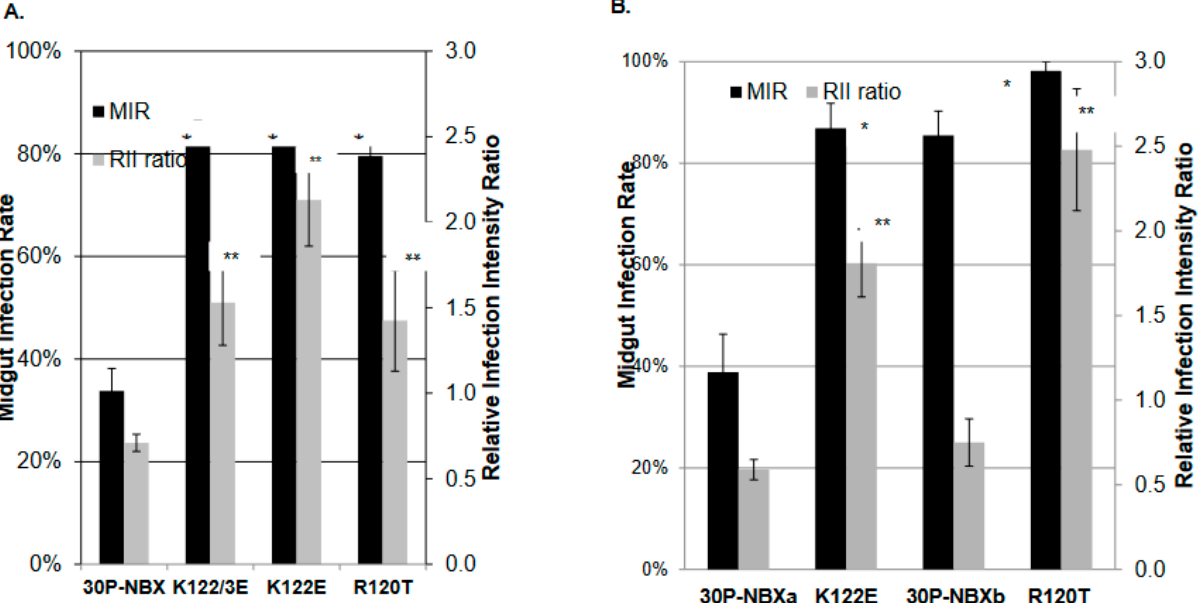
Figure 4. Virus MIRs and relative infection intensity (RII) ratios in Ae. aegypti RexD mosquito midguts ( A ) and Chetumal mosquito midguts. Mosquitoes were orally challenged with each virus, maintained for seven days until midguts were dissected, and MIRs and RII ratios were determined by IFA. In ( B ), 30p-NBXa and 30P-XNXb are data for internal controls for K122E and R120T, respectively. Data are the average of at least three experiments and significance of MIR (*) and RII ratio (**) differences were determined by comparison with 30P-NBX using student’s t test ( p value < 0.05). IFA analysis of infected mosquito midguts to determine MIRs also showed that on average, in RexD infections by K122E, KK122/123EE, and R120T, DENV2 E antigen was detected over a significantly greater area of the entire midgut at all times PBM than in mosquitoes infected with 30P-NBX. To express this difference, a measurement of relative midgut infection intensity, the RII ratio, was developed as described in the Methods sec- tion and illustrated in Figure 5. Mutants consistently had higher RIIs than 30P-NBX (Fig- ure 5) Our observations suggested that K122E initiates infection in a higher proportion of cells and spreads more rapidly and efficiently in the mosquito midgut than 30P-NBX.